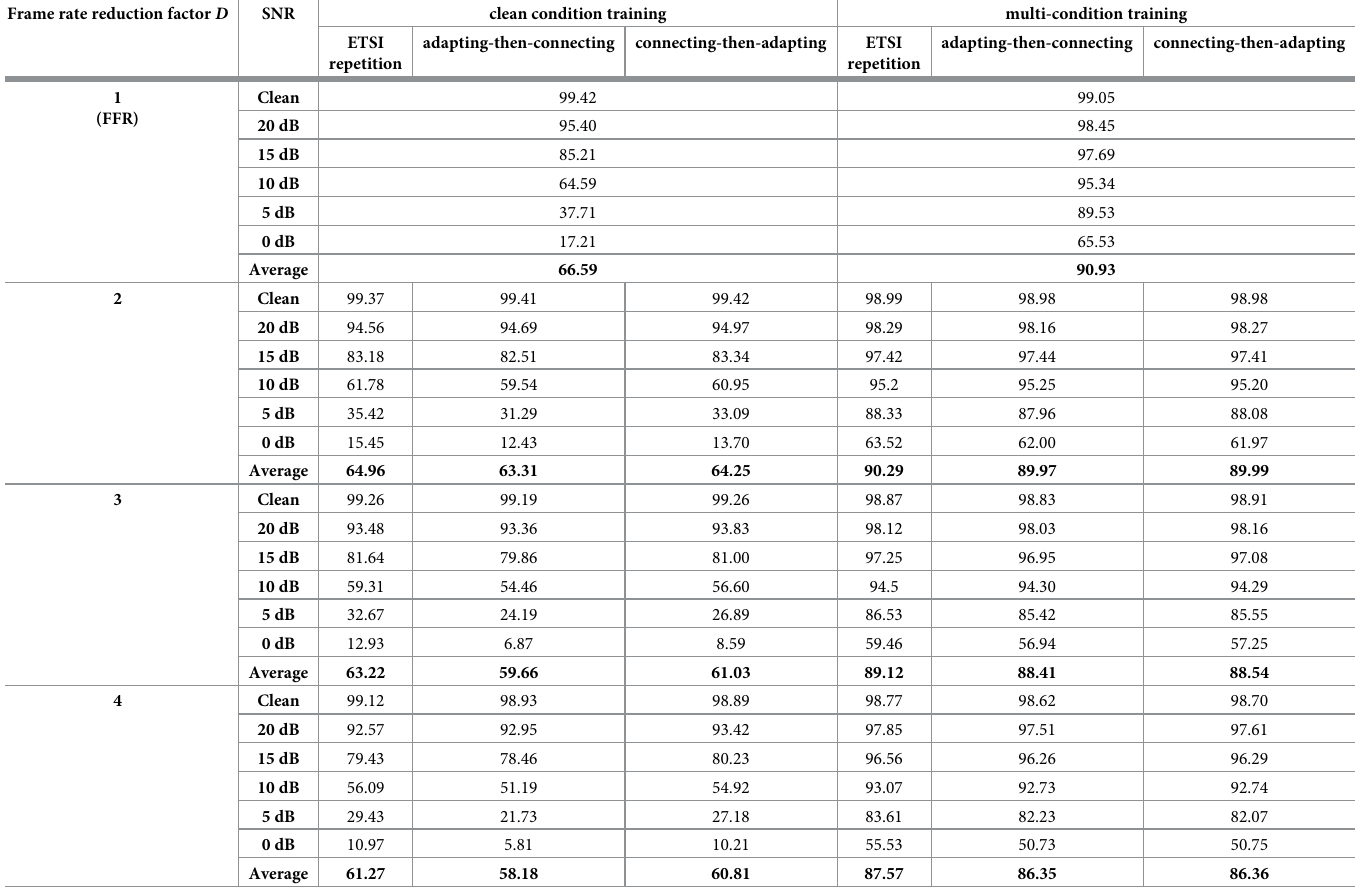
Table 1. Word accuracy for FFR data and for the ETSI repetition and the two adaptation approaches on RFR data at various SNR levels in models based on clean and multi-condition training data. Frame rate reduction factor